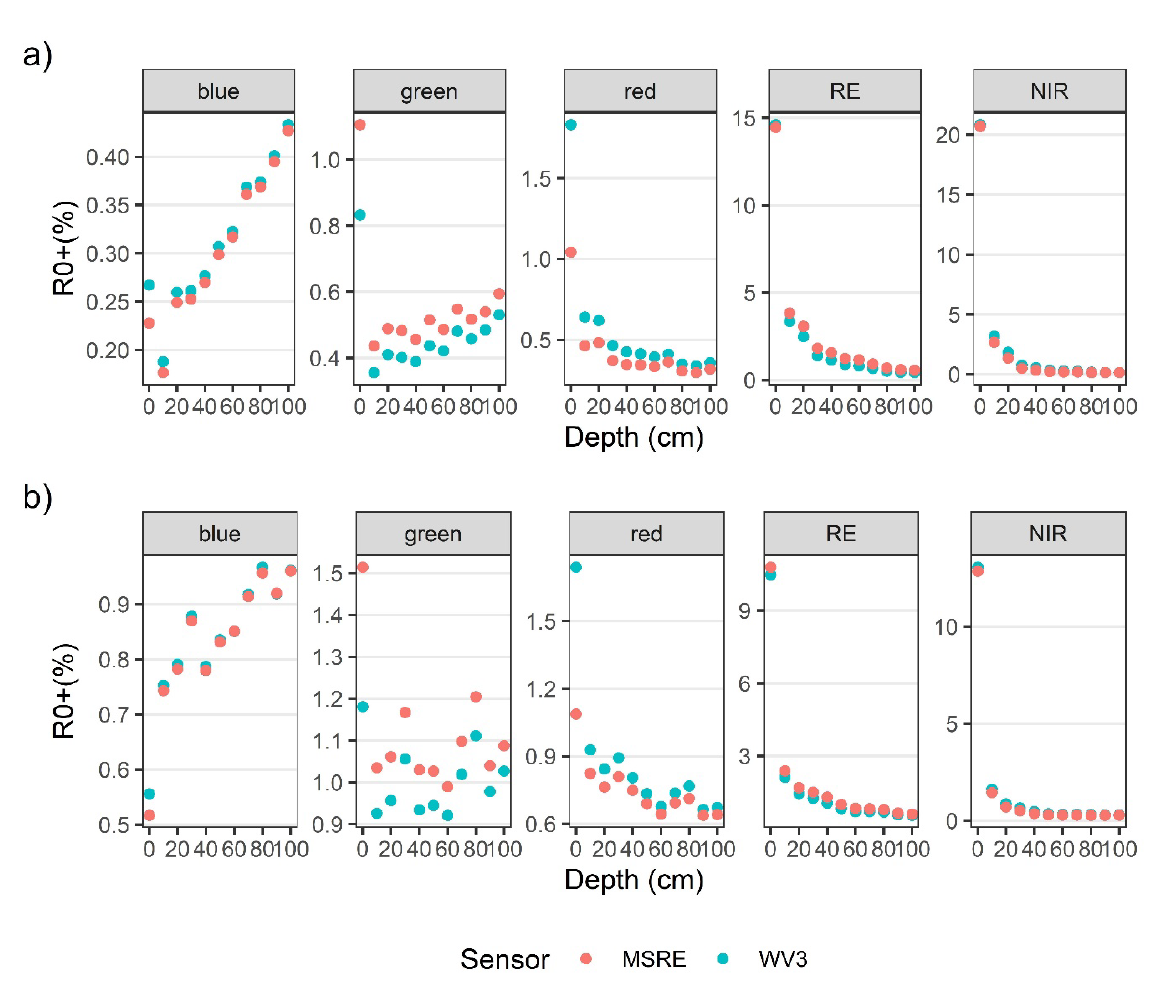
Figure A1. Differences between R 0+ values of each shared band of the Micasense RedEdge-MX (MSRE) and WorldView-3 sensors, as simulated from the bulb ( a ) and blade ( b ) spectral measure- ments.